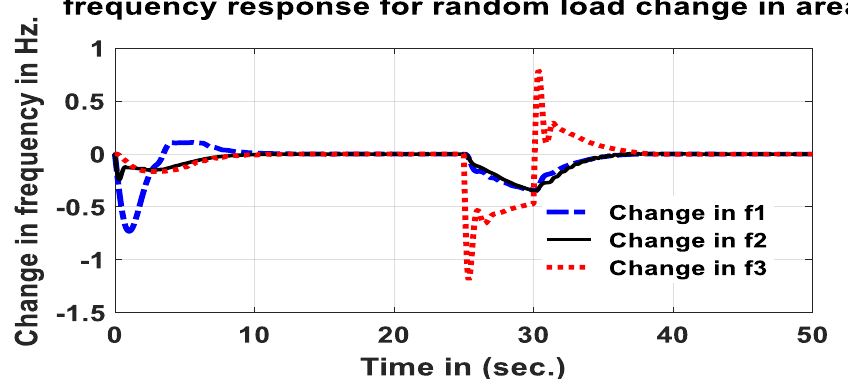
Figure 27. Change in frequency responses of area 1, area 2, and area 3 for random load change in area 3 only.